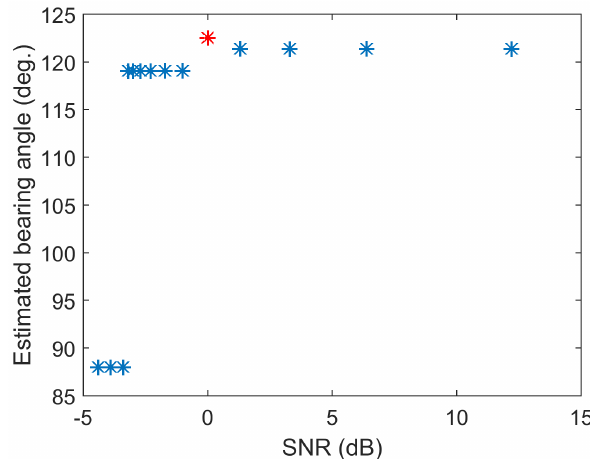
Figure 19. Click signal-to-noise ratio (SNR) plotted as a function of estimated bearing angle. SNRs, computed by increasing and de- creasing noise levels, are given relative to the original click SNR (plotted as a red star), as measured from the data